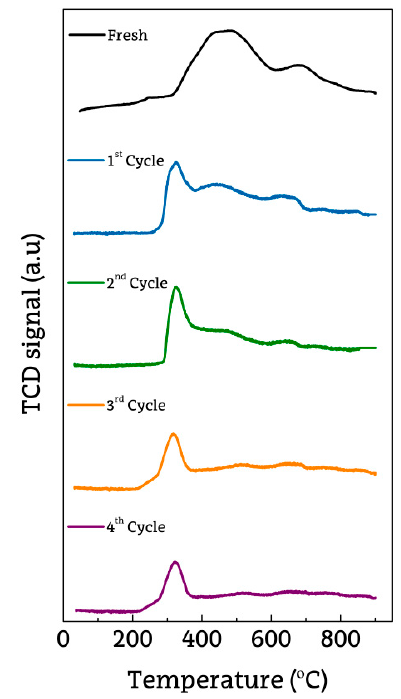
Figure 6. TPR profiles of the catalyst regenerated subsequent to four consecutive reaction cycles.